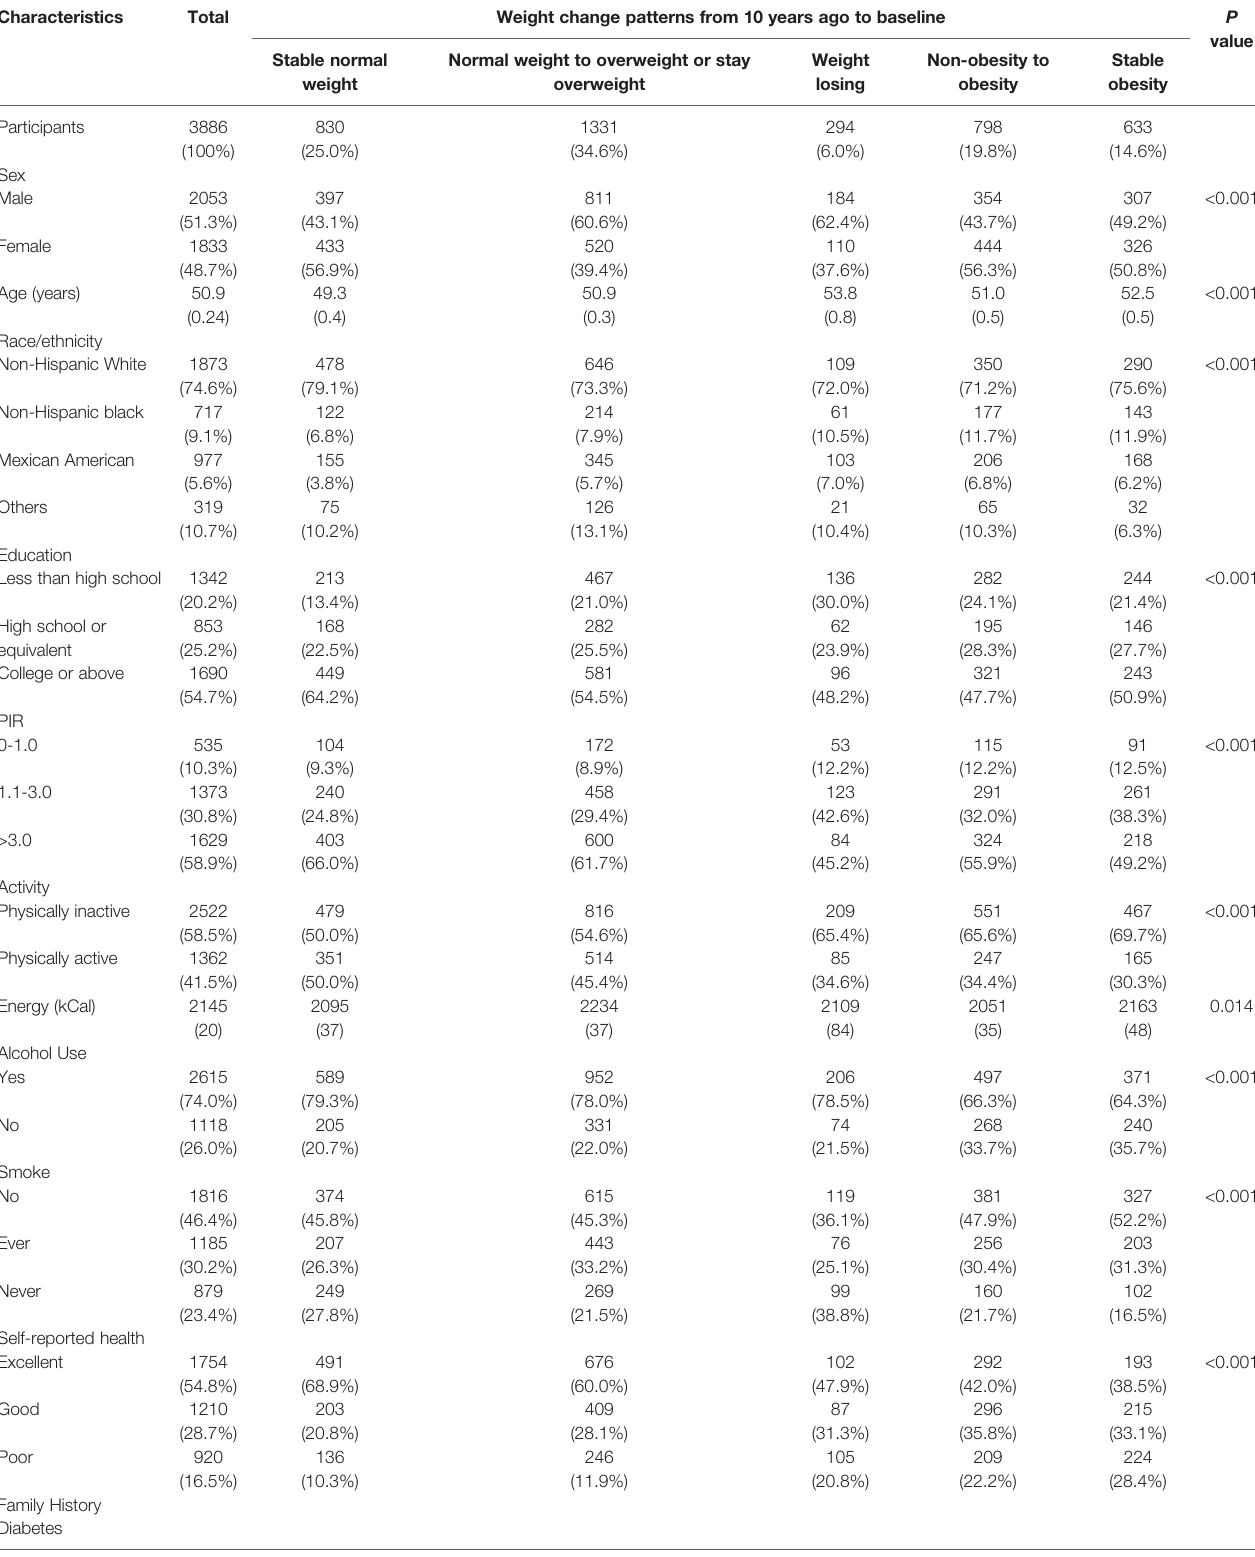
TABLE 1 | Baseline characteristics of study participants in the NHANES 1999-2002 cycle.